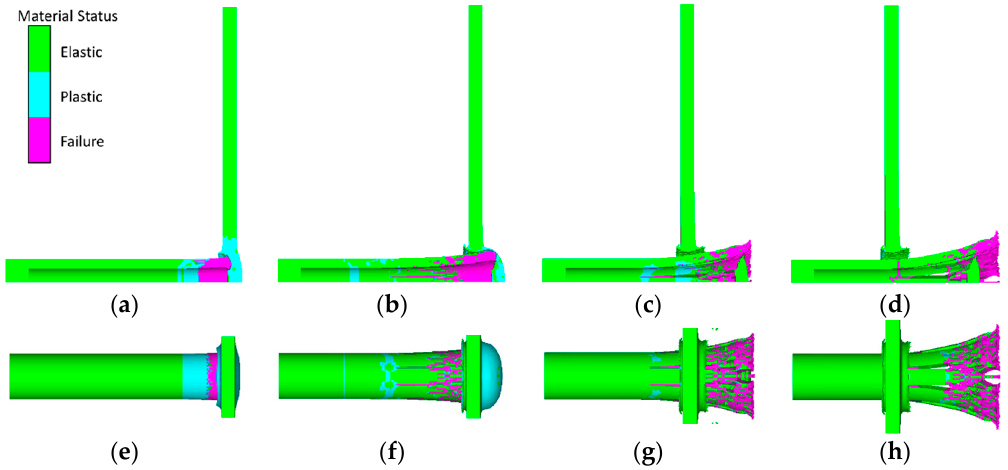
Figure 15. Fragmentation process of a PELE projectile impacting the target plate : ( a ) t = 2 μ s side view, ( b ) t = 7 μ s side view, ( c ) t = 16 μ s side view, ( d ) t = 2 μ s side view, ( e ) t = 2 μ s over view, ( f ) t = 7 μ s over view, ( g ) t = 16 μ s over view, and ( h ) t = 24 μ s over view.